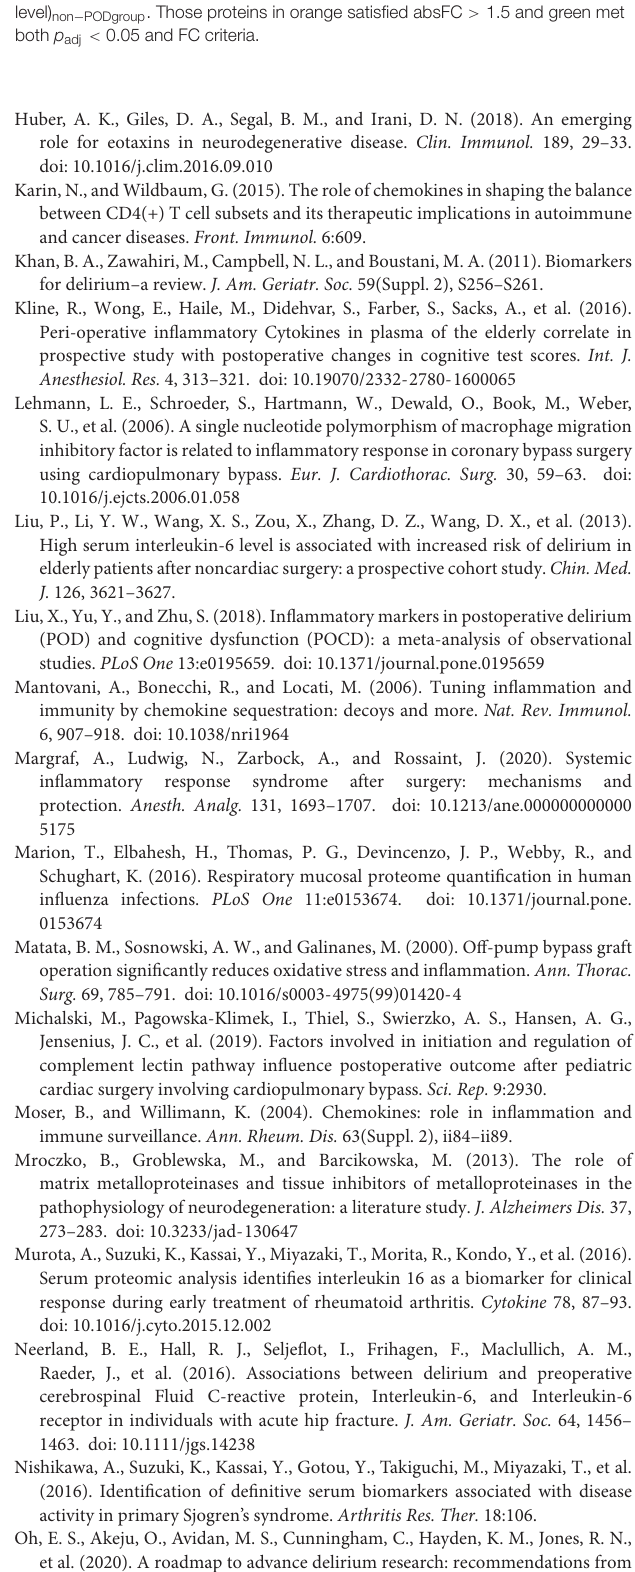
Supplementary Figure 3 | TruCulture proteins associated with delirium. The plot shows those proteins most differentially changed during surgery in the delirium group vs. the non-delirium group. Fold change (FC) was calculated by